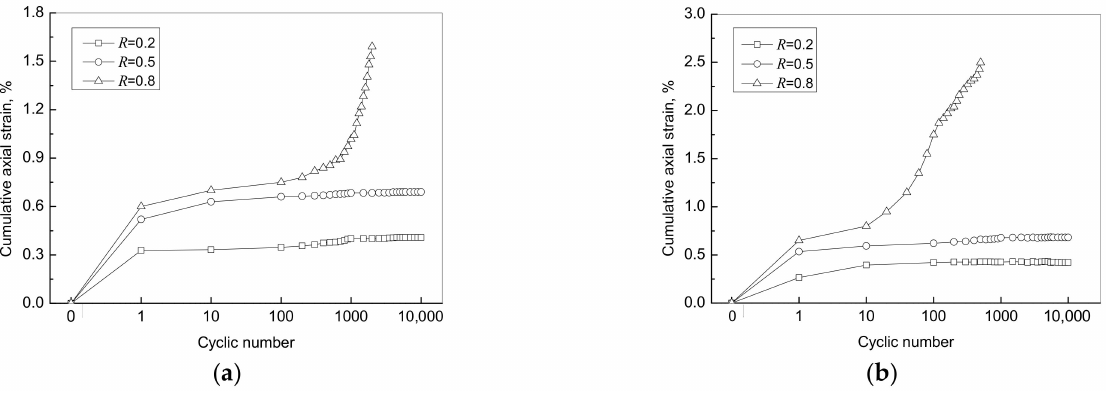
Figure 5. Variation of accumulative axial strain of specimen with cyclic number: ( a ) FC7; ( b ) FC9.